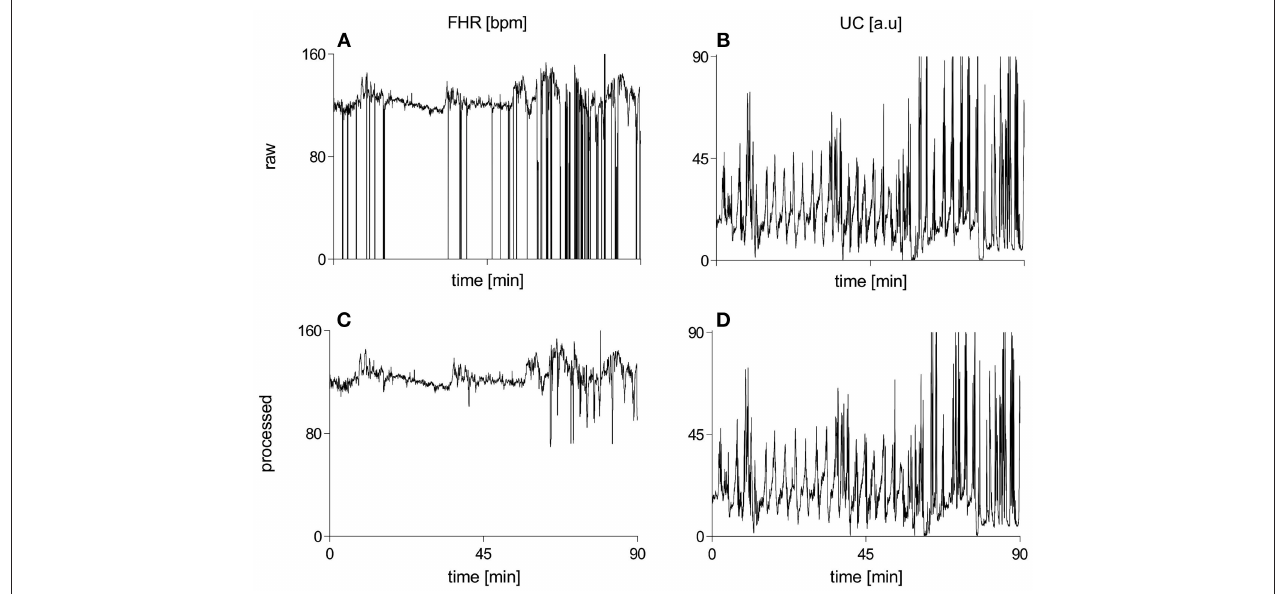
FIGURE 2 | Raw and processed waveforms of FHR [bpm] and UC [a.u] recordings for one representative subject of the vaginal group. (A) raw FHR, (B) raw UC, (C) processed FHR, (D) processed UC. FHR, fetal heart rate; bpm, beats per minute; UC, uterine contraction; a.u, arbitrary units.